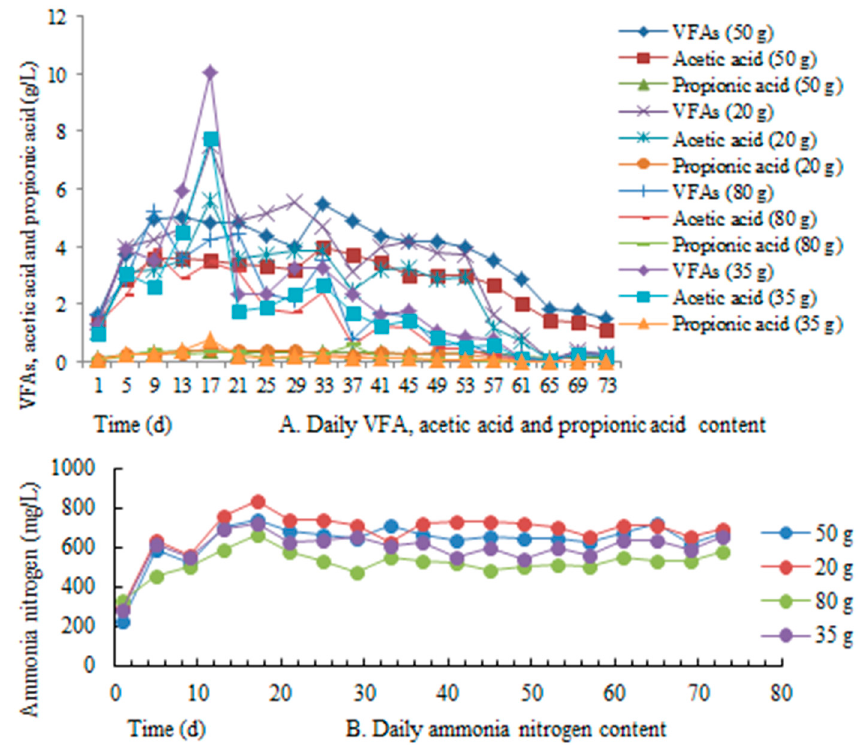
Figure 7. The change in the VFA and ammonia nitrogen content with different mushroom residue